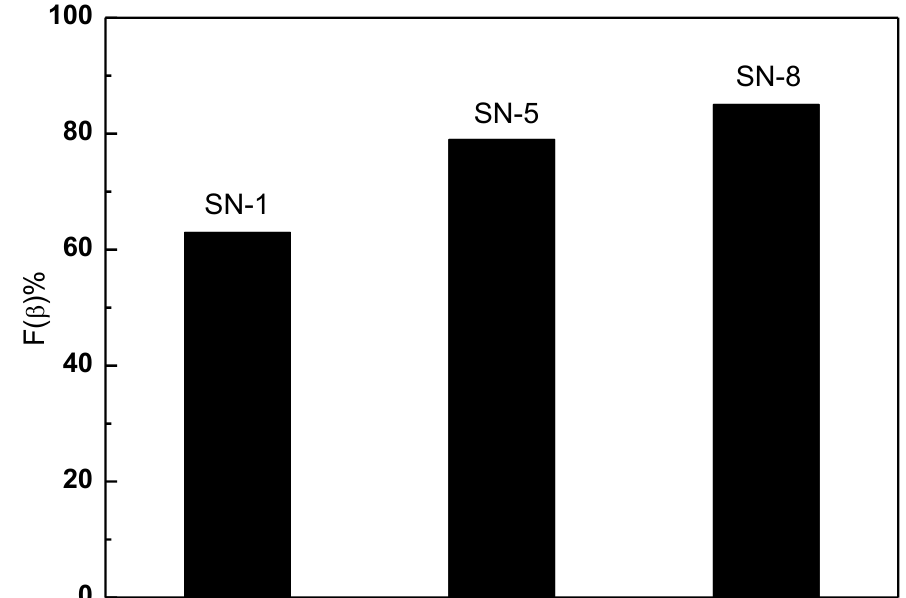
Figure 7. Electroactive β -crystal content, F( β ).